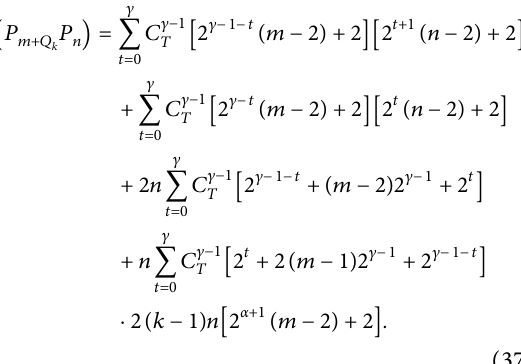
P ) using Table m + R k n